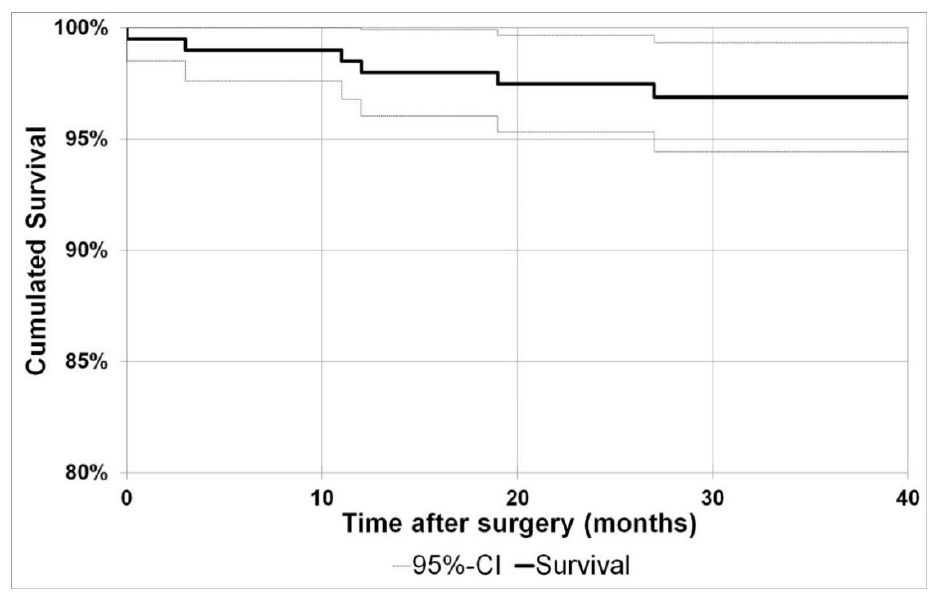
Figure 4. Kaplan–Meier curve: endpoint implant revision .